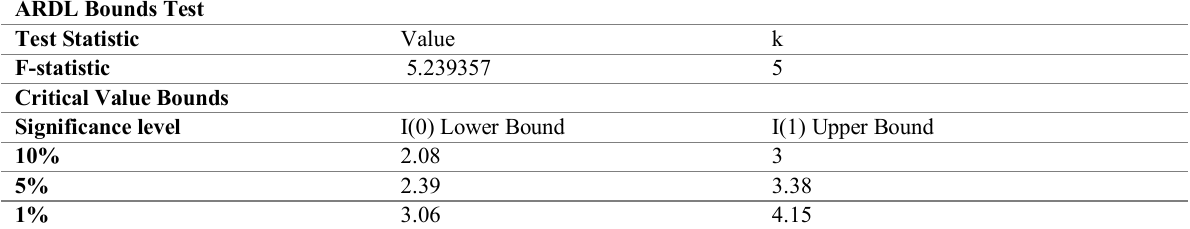
Table 4 : ARDL Co-integration result